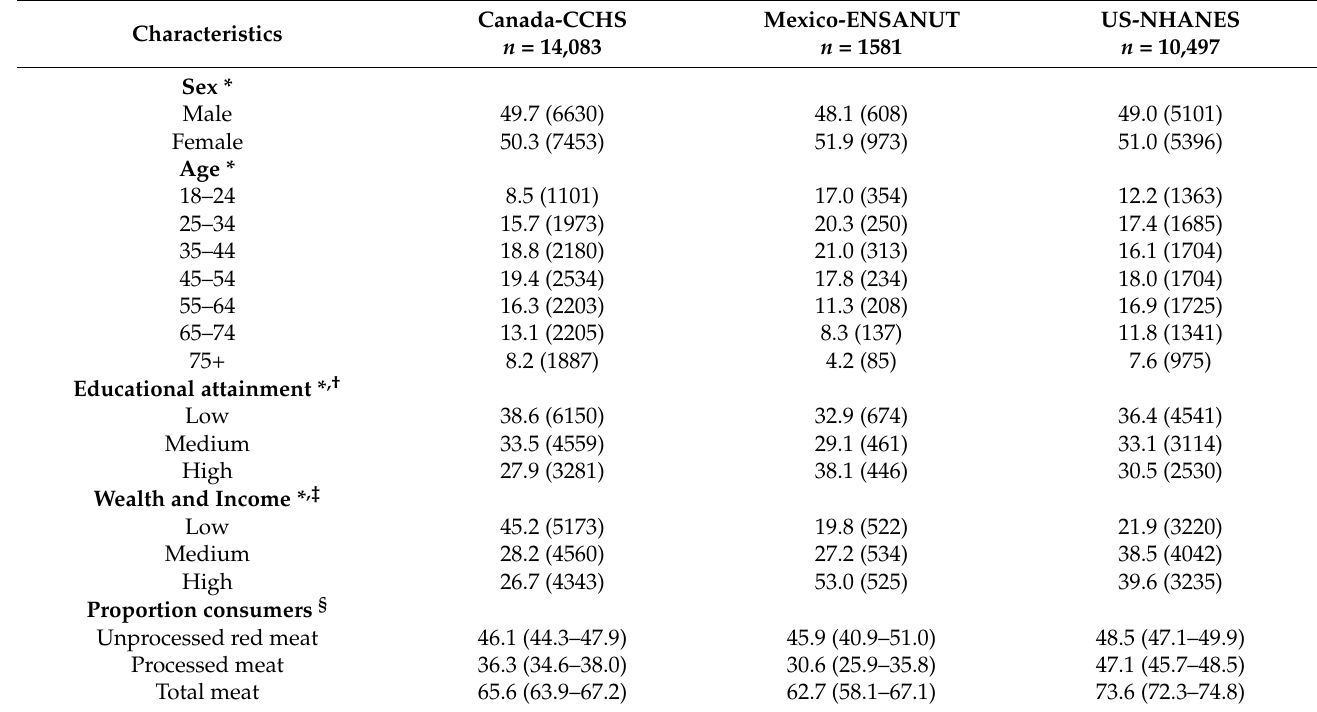
Table 1. Characteristics of non-pregnant adults aged ≥ 18 years with at least one day of 24-h dietary recall data in Canada, Mexico, and the United States ( n =